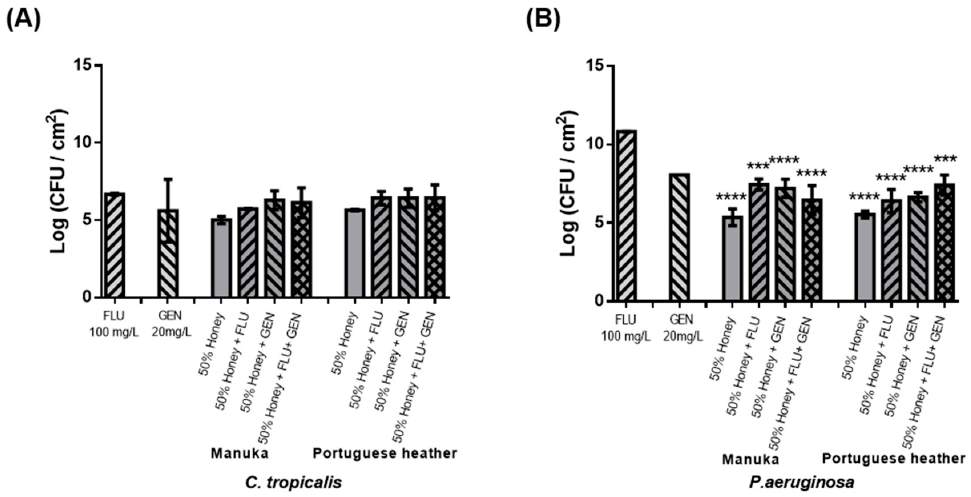
Figure 3. Therapeutic effect of manuka or PH honeys combined with 100 mg L − 1 of FLU and 20 mg L − 1 of GEN on 24 h-old dual-species biofilms formed by C. tropicalis ( A ) and P. aeruginosa ( B ) at 24 h. * p < 0.1, ** p < 0.01, *** p < 0.001, **** p < 0.0001 indicates a statistically different reduction in comparison with the FLU.